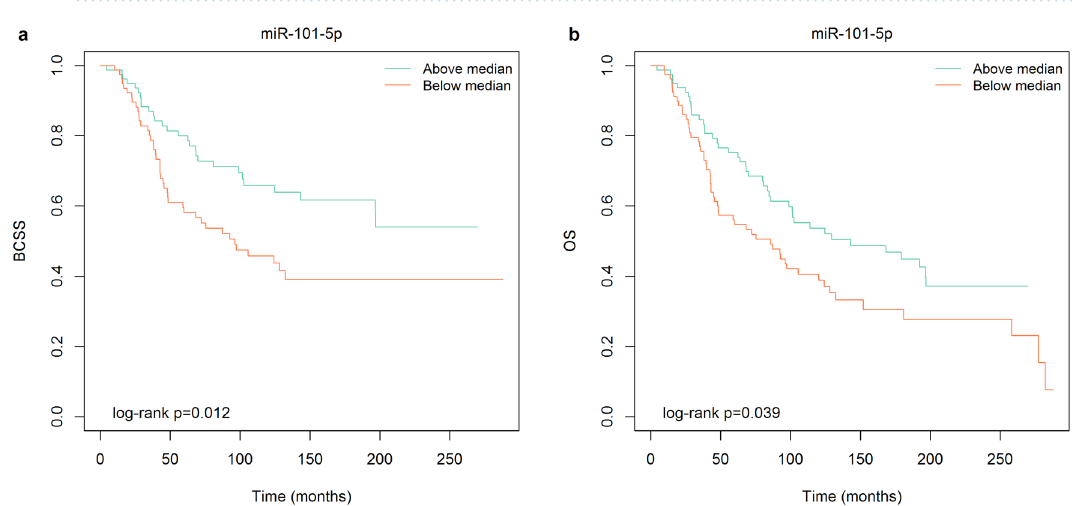
Figure 4. Higher expression of miR-101-5p is associated with better survival of HER2 + breast cancer patients. Survival curves presented as Kaplan–Meier plots for HER2 + breast cancer patients in the METABRIC dataset ( n = 160). There is a significantly better breast cancer specific survival (BCSS; p = 0.012; ( a )) and overall survival (OS; p = 0.039; ( b )) with above median expression of